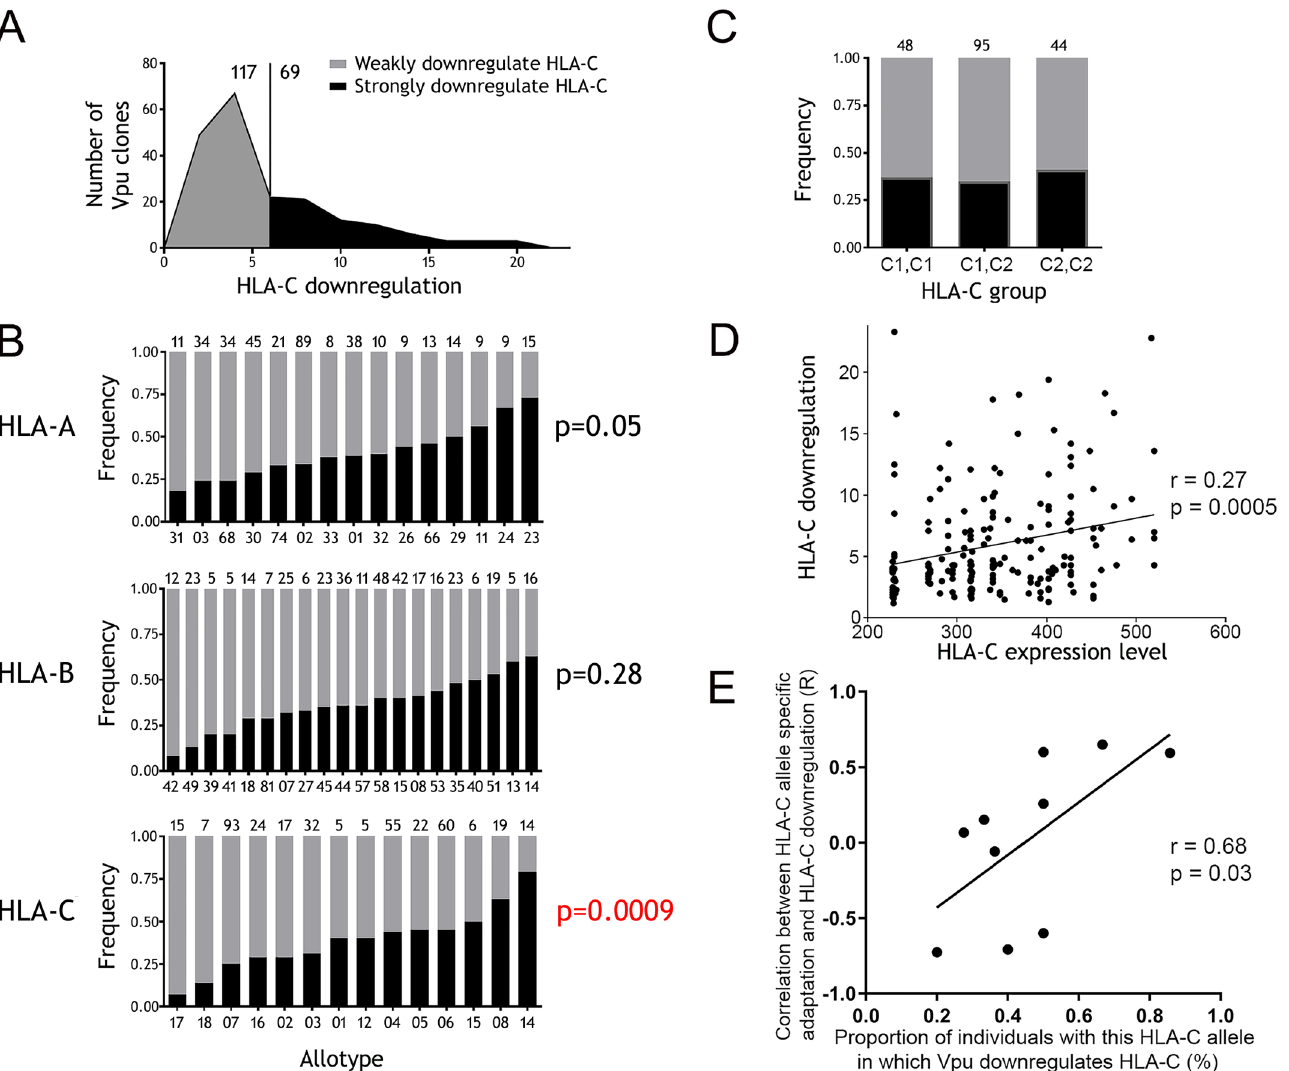
Fig 3. Downregulation of HLA-C shows adaptation to host HLA genotype. (A) For 186 individuals a single Vpu clone from chronic untreated infection was measured for ability to downregulate HLA-C by transfection of Molt-4 cells. The distribution of HLA-C downregulation is shown, with a threshold of 6-fold used to define 69 strongly downregulating (black) and 117 weakly downregulating Vpu clones (grey). (B) The proportion of Vpu clones that downregulate HLA-C strongly is shown when individuals are stratified by the presence of common alleles of each of the HLA-A,—B, and—C loci. The number of individuals in each group is shown above each plot and statistical analysis is by chi square tests. (C) HLA-C alleles can be grouped as C1 or C2 according to their differential binding of KIR2D receptors, and the proportion of Vpu clones that strongly downregulate HLA-C is shown for individuals when grouped by these genotypes. (D) HLA-C alleles differ in expression level and can be inferred for an individual from the HLA-C genotype. HLA-C expression level and the observed HLA-C downregulation by Vpu are plotted for 186 individuals. (E) For the subset of individuals where viral adaptation to host HLA-C alleles could be quantified (n = 72), the correlation between host HLA-C allele-specific viral sequence adaptation and observed downregulation of HLA-C by Vpu was determined. For 10 HLA-C alleles this correlation is plotted against the proportion of individuals with that HLA-C allele in which Vpu downregulates HLA-C. Correlations were determined using two- tailed Spearman